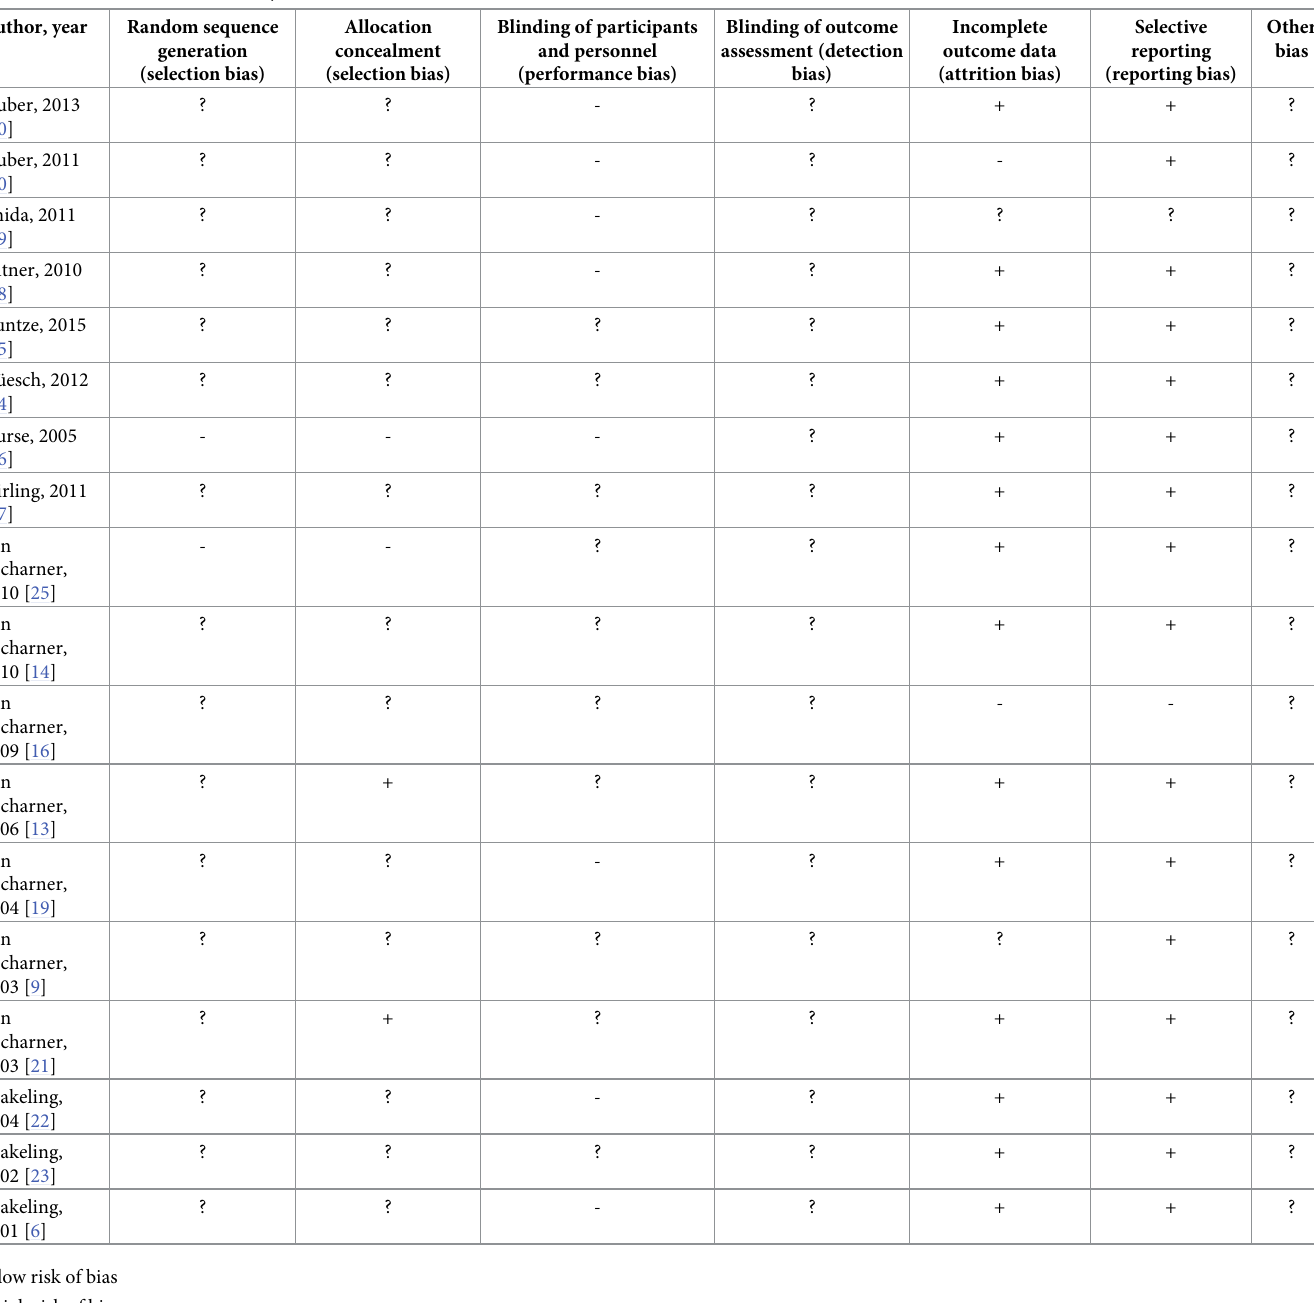
Table 1. Cochrane risk of bias